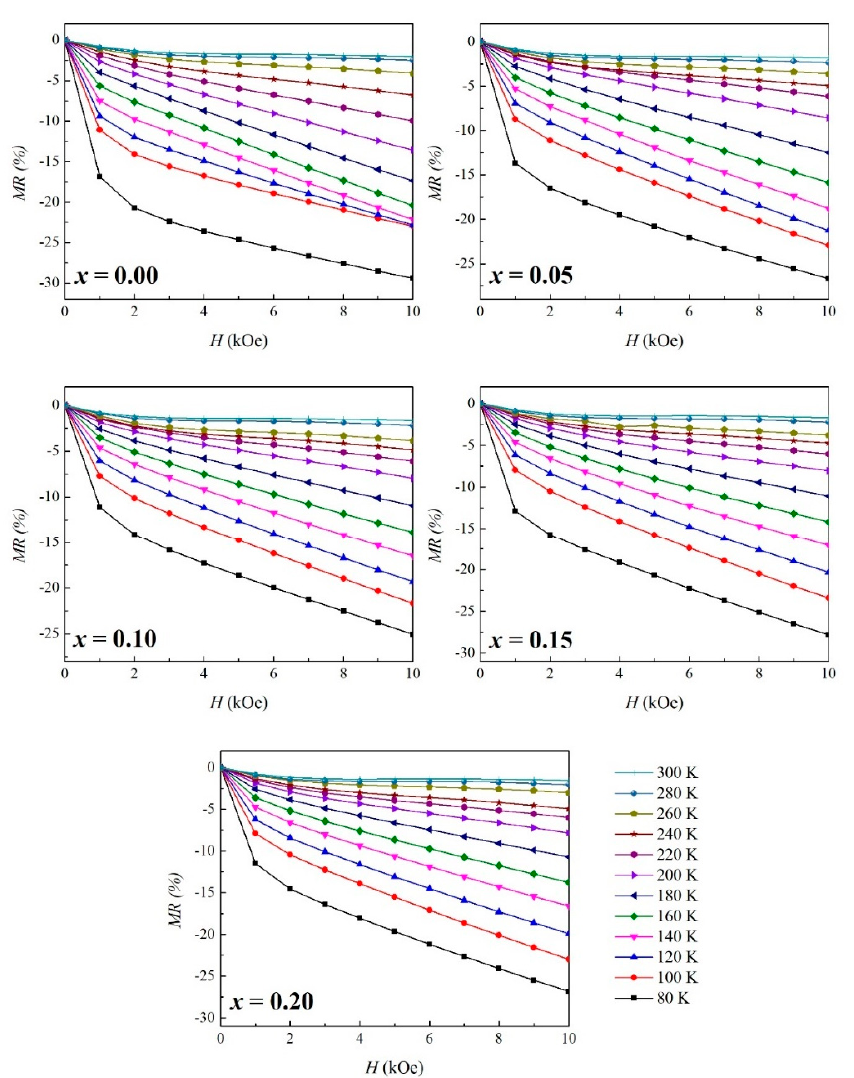
Figure 6. MR (%) as a function of external applied magnetic field curves from 80–300 K for (1 − x ) LCMO: x NiO, x = 0.00, 0.05, 0.10, 0.15 and 0.20.